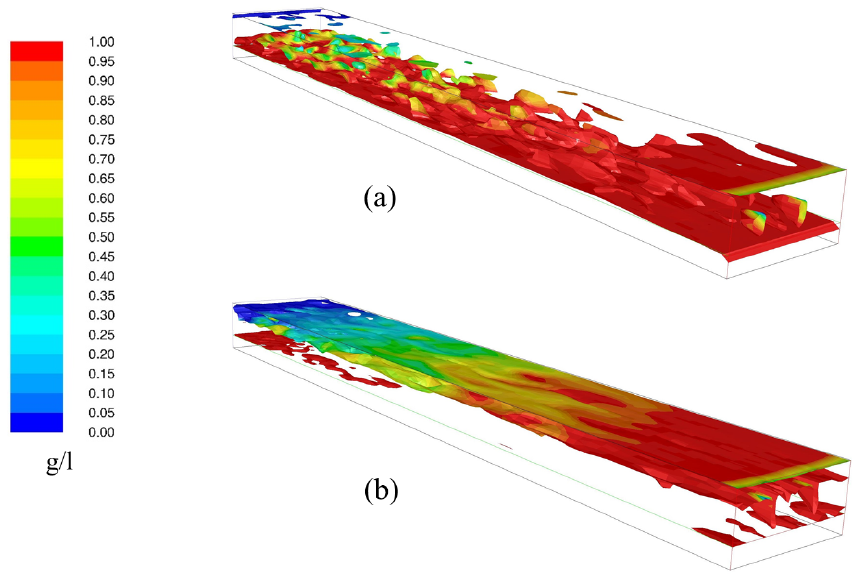
Figure 8. The impurity concentration field shown on an isosurface of velocity magnitudes of